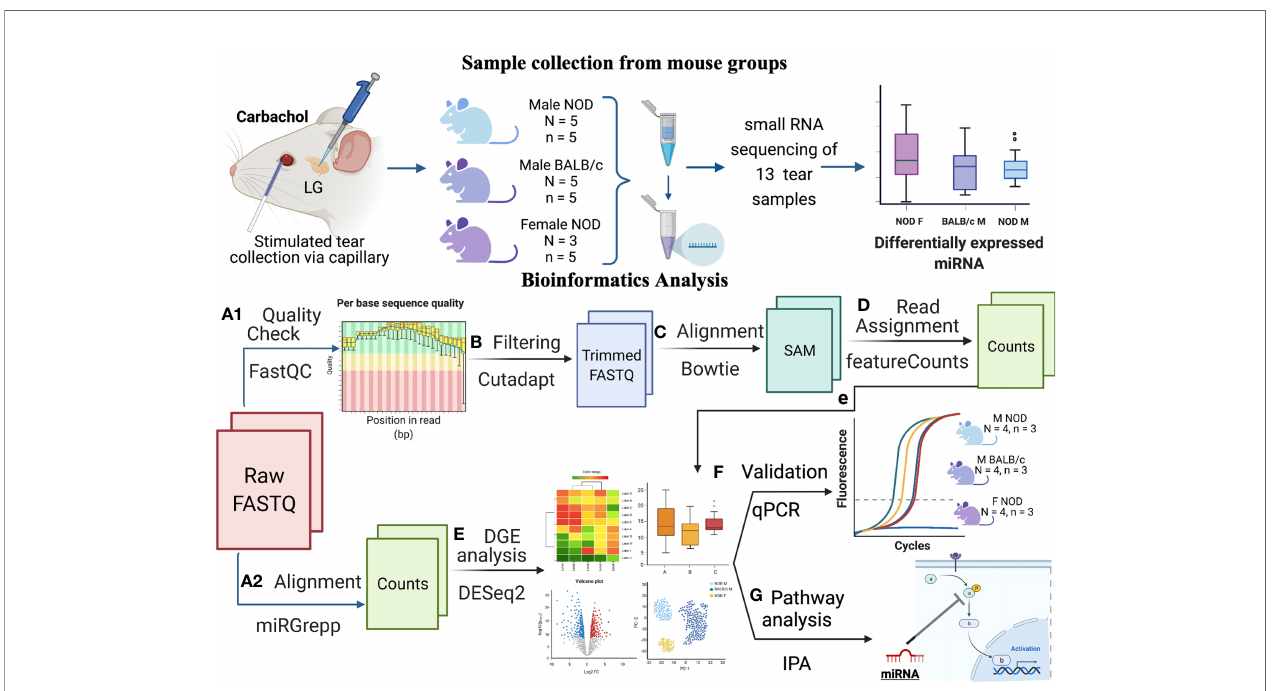
FIGURE 1 | Schematic overview of experiments and data analysis. Tears were collected by stimulating both LG from each mouse with 50 m M Carbachol. Tears were pooled from n=5 mice for each sample, with N=5 samples for male NOD and BALB/c mice and N=3 for female NOD mice. In total, 13 samples were sent for RNA sequencing, and raw data was analyzed as follows: (A1) Quality assessment by FASTqc showed presence of 3 ’ adapters in the reads; (B) Using cutadapt (33), 3 ’ adapters were trimmed and reads with quality scores <20 or length <15 were removed; (C) Trimmed reads were aligned to mouse genome GRCm38 using Bowtie (34); and (D) Aligned reads were annotated using featureCounts (35). Additionally, (A2) raw FASTQ fi les were also run through our internal miRGrepp pipeline (36) and (E) miRNA counts were normalized, and plotted to assess the quality of the data with statistics on these read counts performed using R package, DESEq2 (37); (F) Shortlisted hits were validated by qPCR in a separate cohort of mice; and and (G) Pathway analysis of the hits was done in Ingenuity Pathway Analysis (Qiagen). Graphic created with